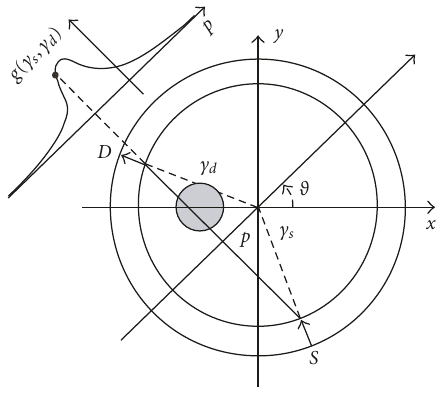
Figure 1: The geometry of the image reconstruction